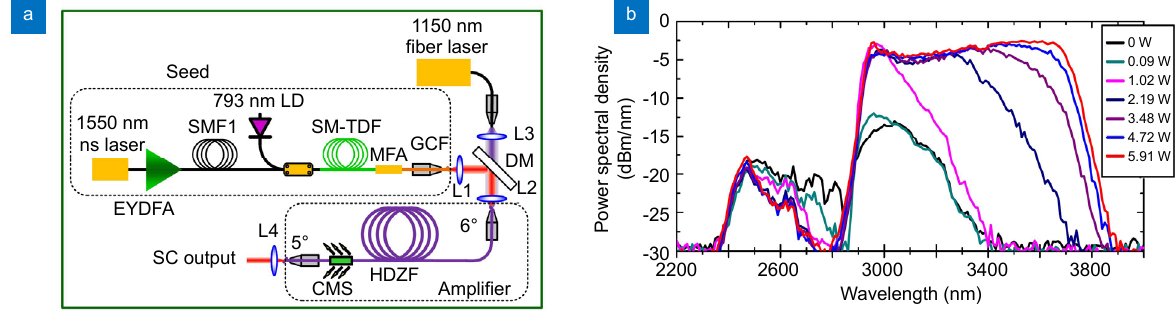
Fig. 6 | Experimental setup and spectra of spectrally flat supercontinuum generation . ( a ) Experimental setup. ( b ) Evolution of SC spectra against launched pump power. Figure reproduced from ref. 4 , Chinese Laser Press